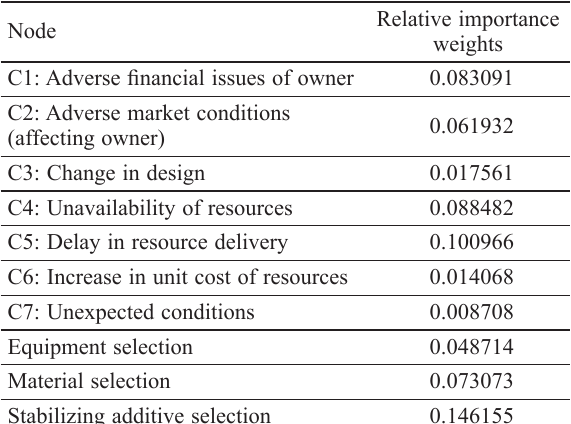
Table 7. Relative importance weights of nodes in the limit supermatrix Node